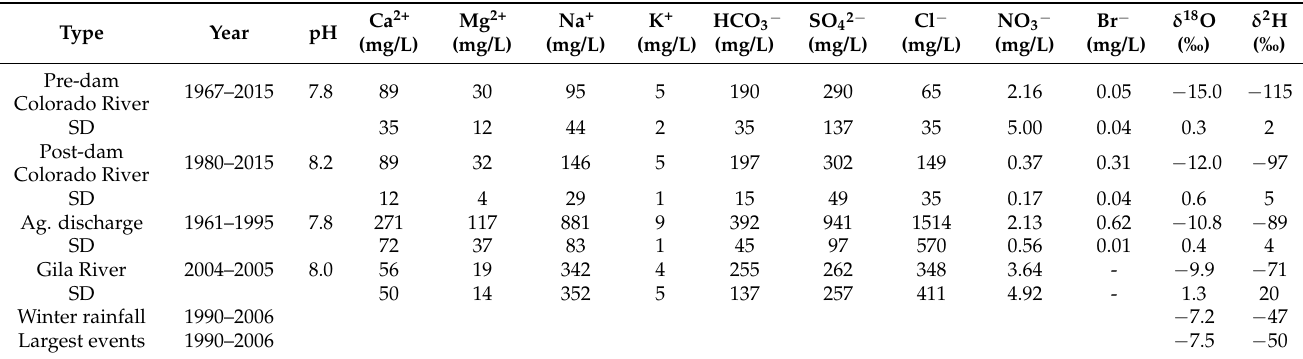
Figure 5. ( A ) δ 18 O and δ 2 H values for the water endmembers in the area [17,33,34] compared to the Global Meteoric Water Line (GMWL; [35]), and the Colorado River evaporation trend (CRET, dashed line). ( B ) Average values for each endmember. This figure also includes winter rainfall and the largest 30% of precipitation events at Organ Pipe Cactus National Monument [30]. Table 1. Average composition of waters in the study area.